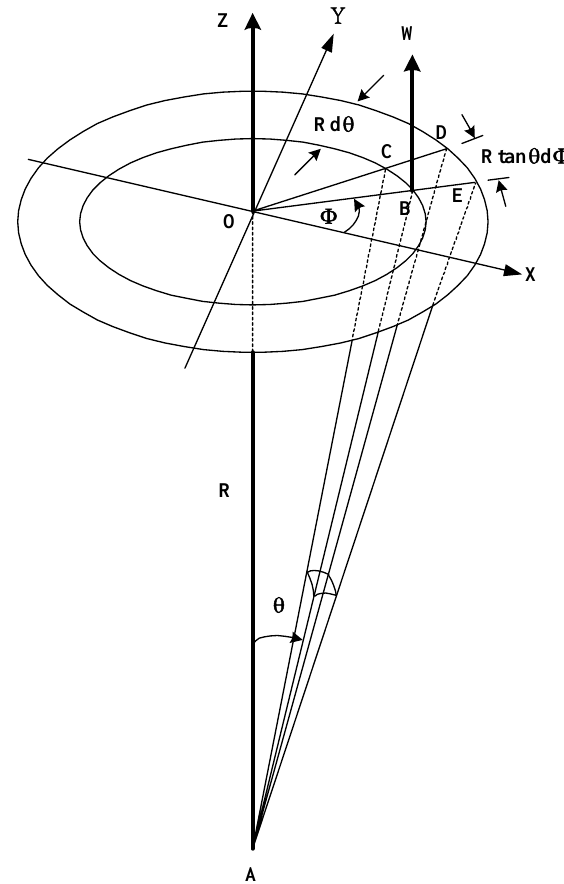
Fig. 1. Geometric relationship between vertically directed antenna beam and vertical wind for the derivation of beam broadening spec- trum caused by vertical wind velocity W